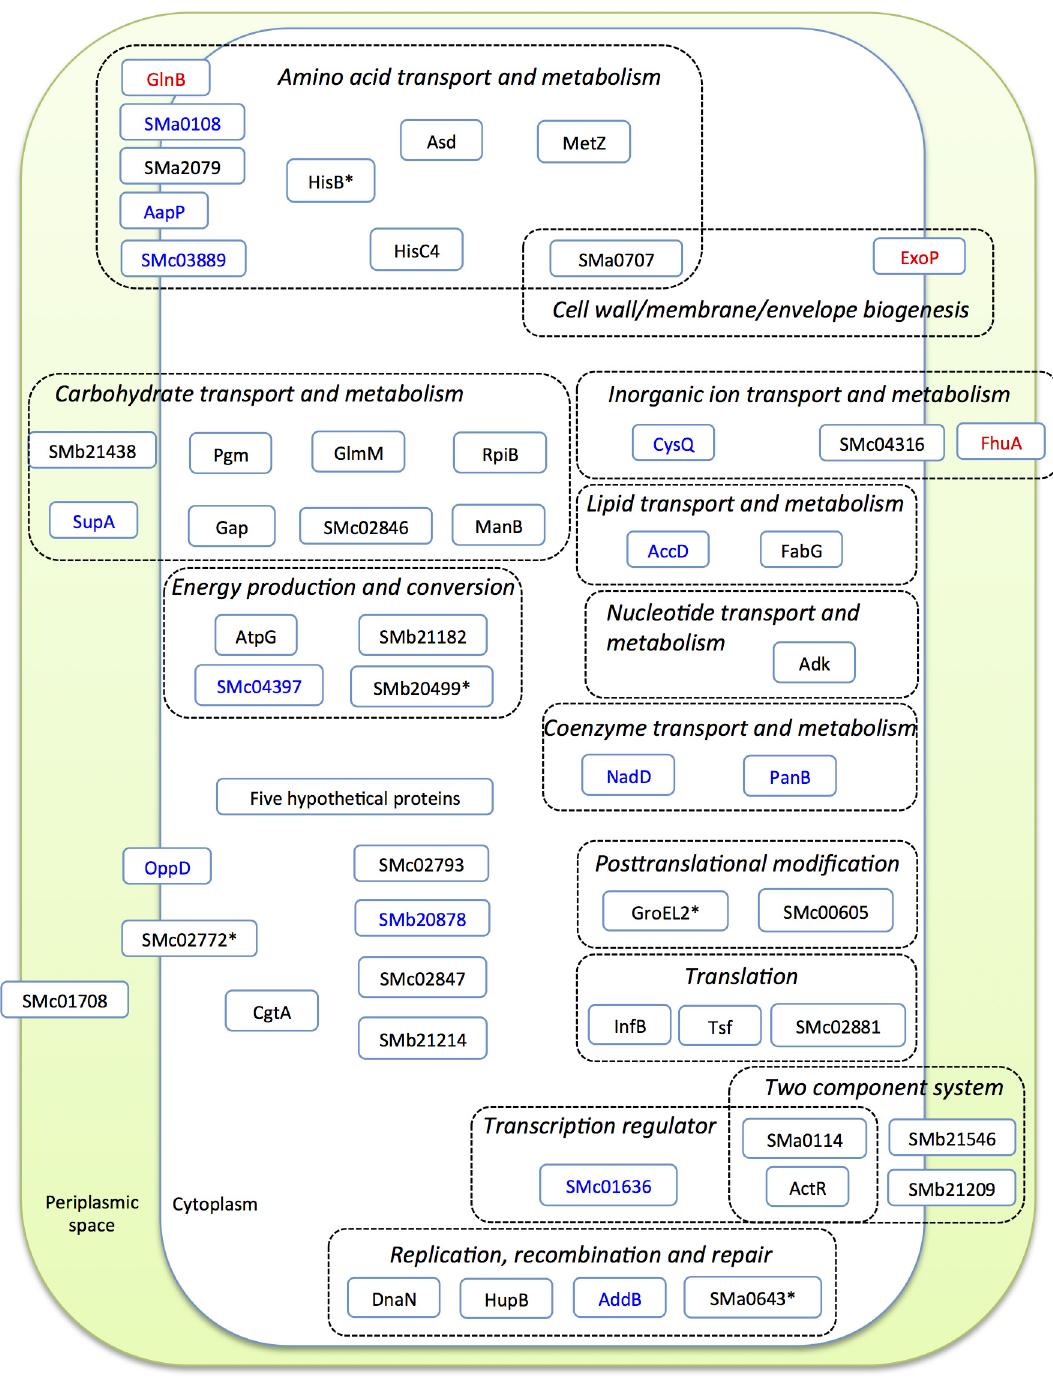
Fig 5. Global view of identified phosphoproteins with predicated cellular localization. The cluster of orthologous group is shown. Proteins phosphorylated at Ser (black), Thr (blue), or Tyr (red) are presented in different colors; * indicates phosphorylated Thr is also identified in this protein.